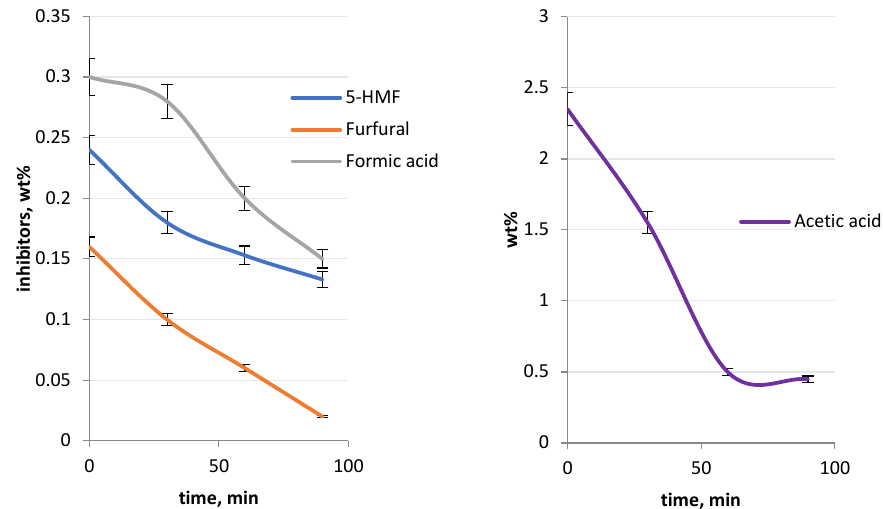
Figure 5. The residual content of inhibitors in the pulp achieved with the bench scale vibro-fluidized system, as g/g × 100 of dry pre-treated biomass. Ethanol production after different detoxification methods, as g/g × 100 of dry pre-treated biomass.